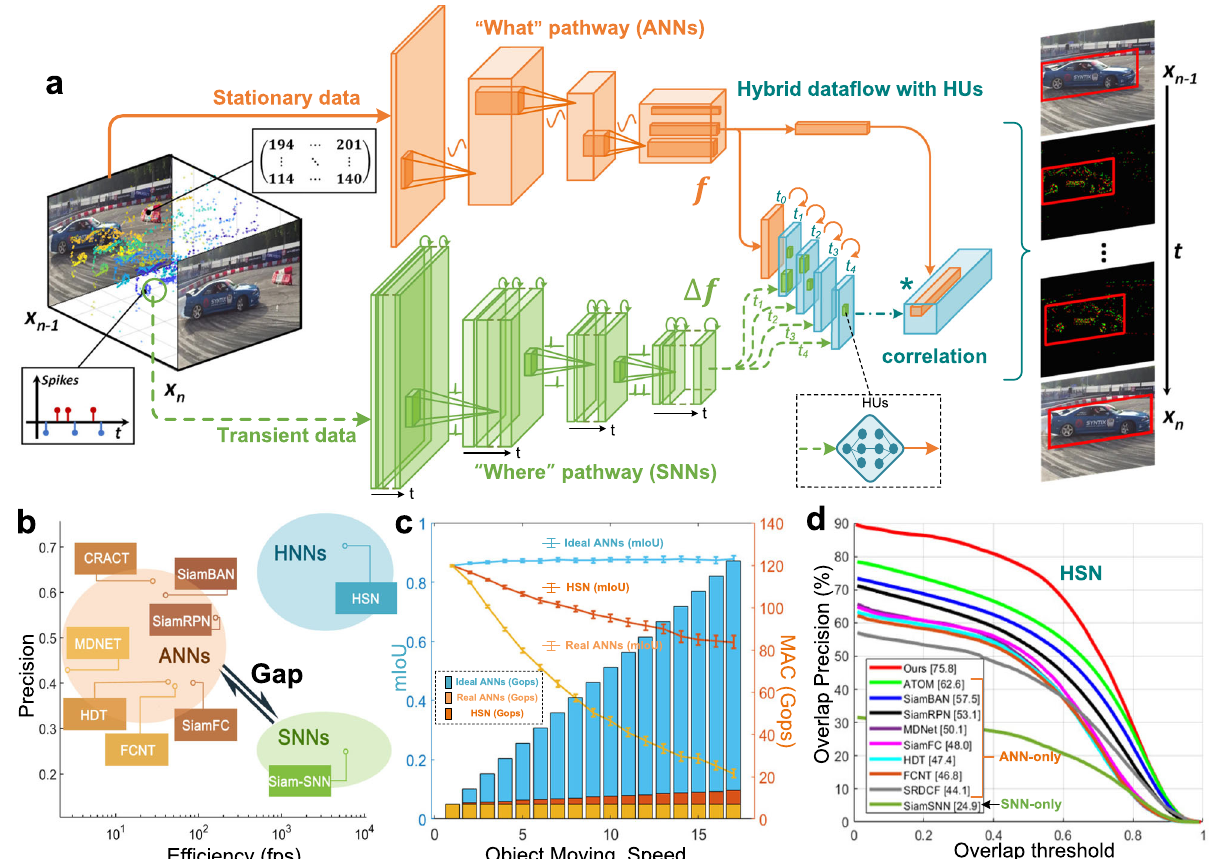
Fig. 2 Multi-pathway HSN for high-speed vision perception. a The architecture of HSN. The orange part represents the “ what ” pathway processing the static information from APS, whereas the green part represents the “ where ” pathway processing the dynamic information from DVS. The “ f ” and “ Δ f ” indicates the feature with orange and “ Δ feature ” with green, respectively. b Precision and speed comparison of ANNs, SNNs, and HNNs. c Network performance for different object-moving speeds and computational cost of ideal ANNs, real ANNs, and HSNs on CLEVRER-DAVIS datasets (see Supplementary Material). The x -axis refers to the results of object-moving speed accelerated by x times. The left side axis is the speed-precision curve and the right-side axis is the speed-MAC bar plot. All the experiments in this demo are independently run four times with the same setting and different initializations. The error bar represents the standard deviation of the mean IoU results. d Network performance comparison and success plots of HSN, and the state-of-the-art trackers on NFS-DAVIS and PRED. The data sources for comparison come from the published work, including CRACT 21 , SiamBAN 22 , SiamRPN 23 , MDNET 24 , HDT 51 , SiamFC, FCNT 26 , Siam-SNN 19 , and SRDCF 27